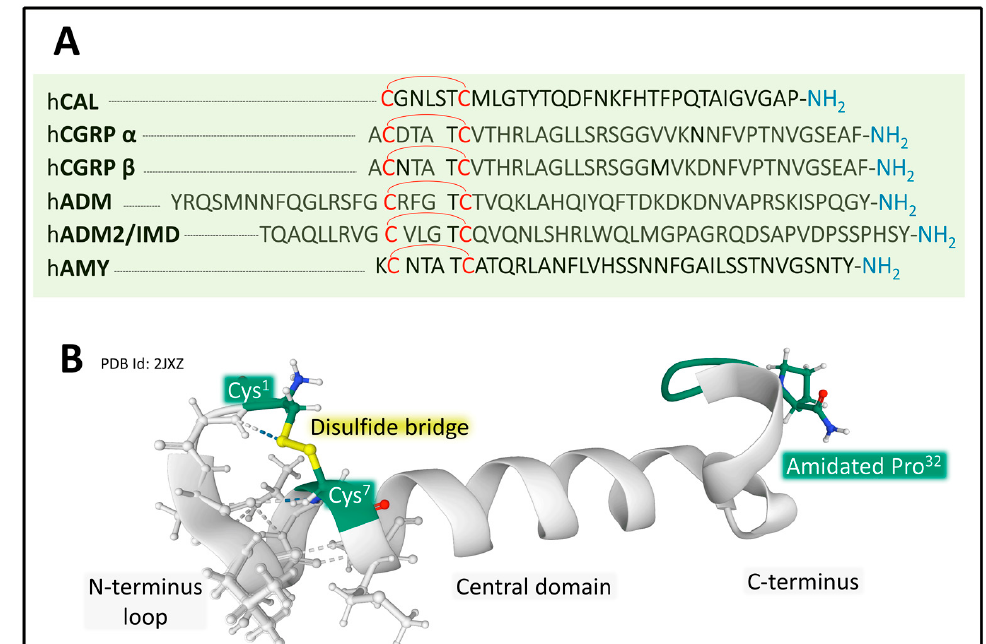
Figure 7. ( A ) shows the amino-acid sequences of the calcitonin/CGRP family. All six peptides present a disulfide bridge between two cysteines in the N-terminal region. Amino-acid sequences are from the GPCR database GPCR database [47]. ( B ) depicts the NMR structure of a human analog of human calcitonin in sodium dodecyl sulfate micelle [115]. Shared structural features include a disulfide bride at the N-terminal region, a helix structure in the central domain, and an amidated C-terminal residue. The configuration corresponding to PDB ID 2JXZ is from the Protein Data Bank [65], drawn with free web-based Mol* software [71].